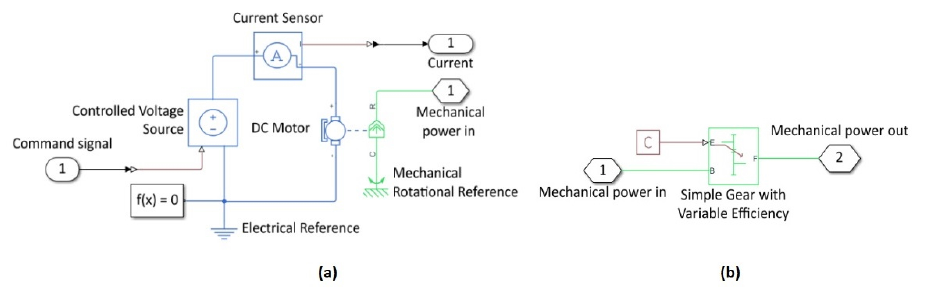
Figure 18. Simscape modelling: ( a ) Electric motor. ( b ) Gearbox. The mechanical system is represented not only by the interface, but also a mobile robot and a cobot, added for a better understanding of the simulation (Figure 19).